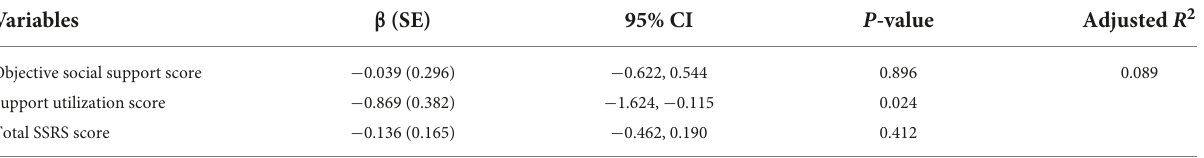
TABLE 7 Regression analysis of the effects of social support on